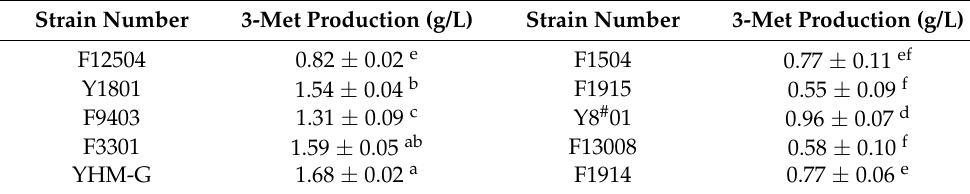
Table 5. The top ten yeasts for 3-Met production in the present